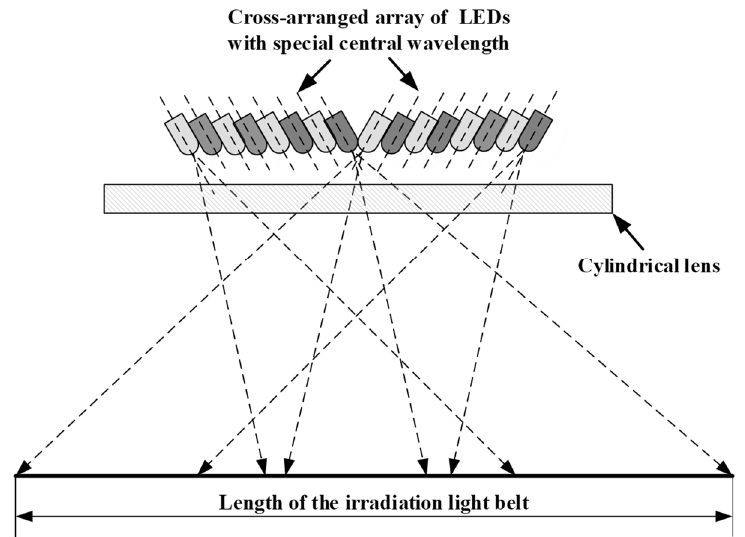
Figure 1. Layout of active light source.